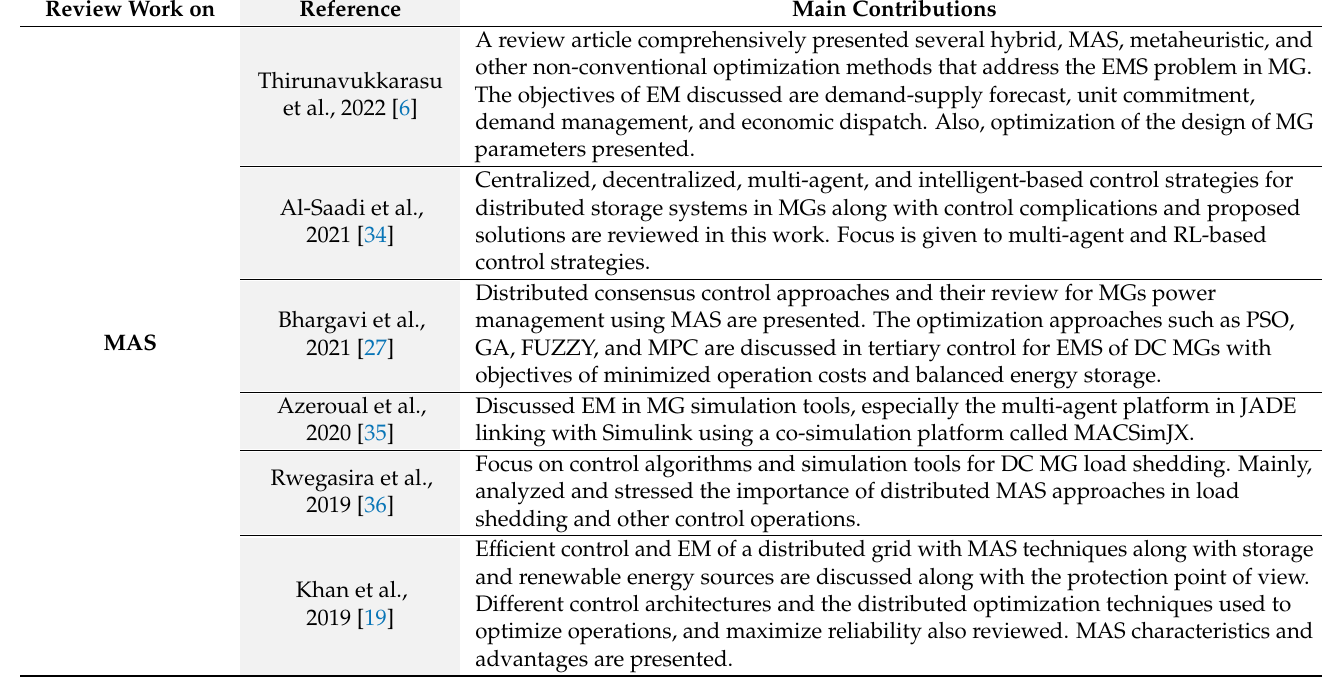
Table 1. Review papers for MAS and MPC-based energy management in